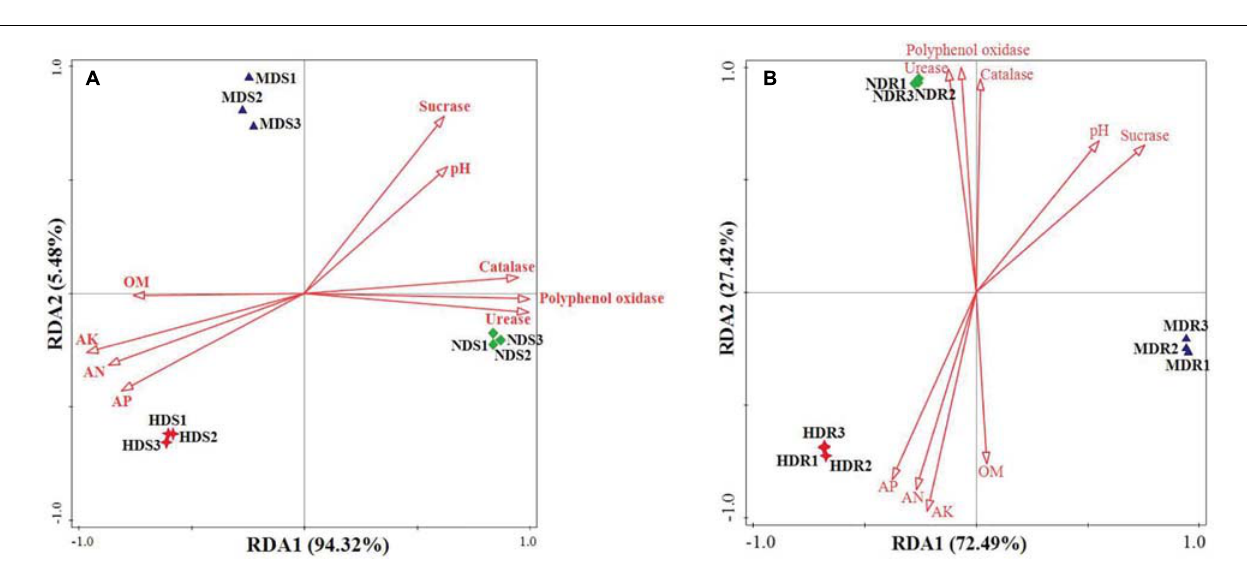
FIGURE 6 | Heatmap of bacterial operational taxonomic units in soil and root samples of konjac from the non-diseased (NDS and NDR), moderately diseased (MDS and MDR), and highly diseased (HDS and HDR) sites.